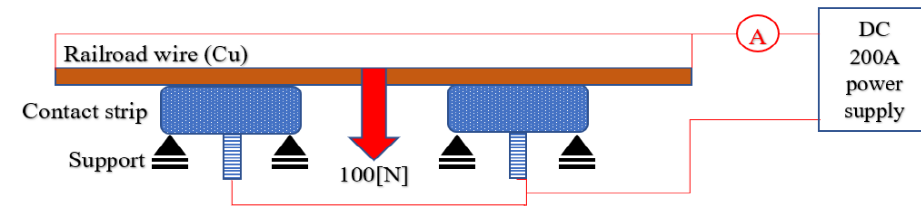
Figure 2. Diagram of the measuring system.